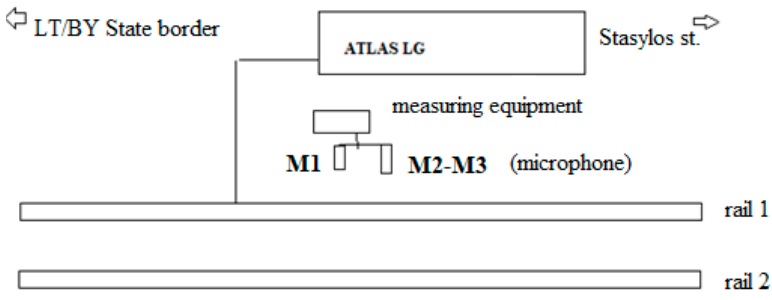
Figure 2. Measurement place diagram.